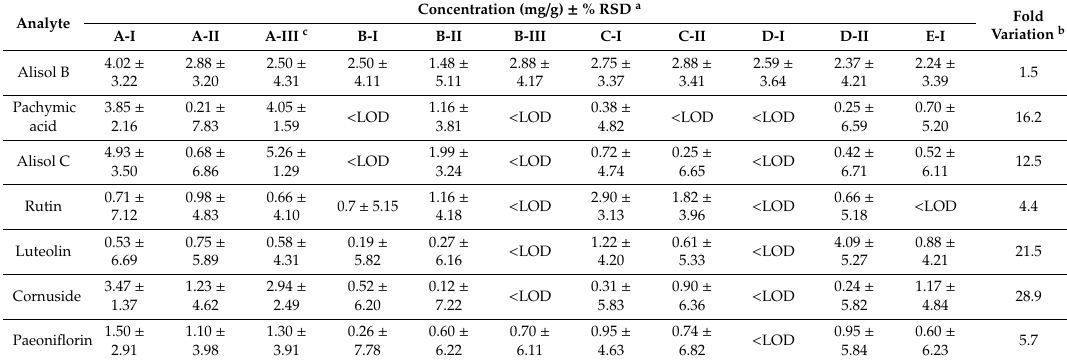
Table 9. The concentrations of target analytes.